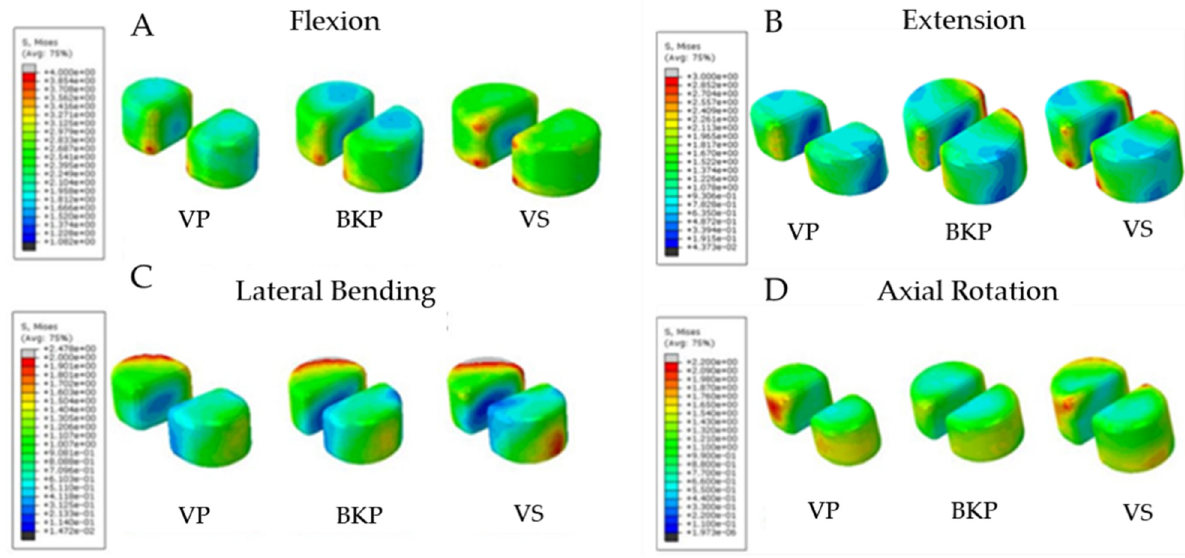
Figure 4. Finite element stress nephogram of bone cement. ( A ): Flexion. ( B ): Extension. ( C ): Lateral bending. ( D ): Axial rotation.